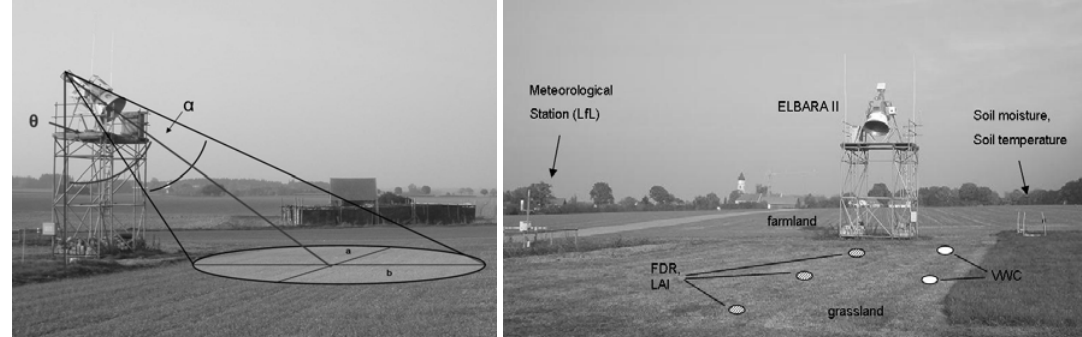
Figure 2. Radiometer ELBARA II with angle of aperture α , incidence angle θ and the two halfaxes a and b of the elliptical footprint on the left; location of ground measurements (LAI and handheld soil moisture (FDR) inside the field of view (FOV), vegetation water content (VWC) outside the FOV; soil moisture and soil temperature stations for both fields are located to the right of the radiometer, the meteorological station to the left of the